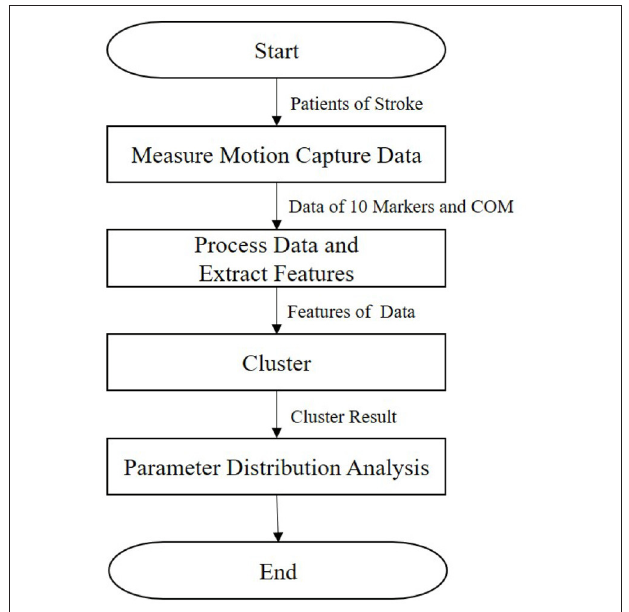
FIGURE 1 | Workflow of the methods used in this